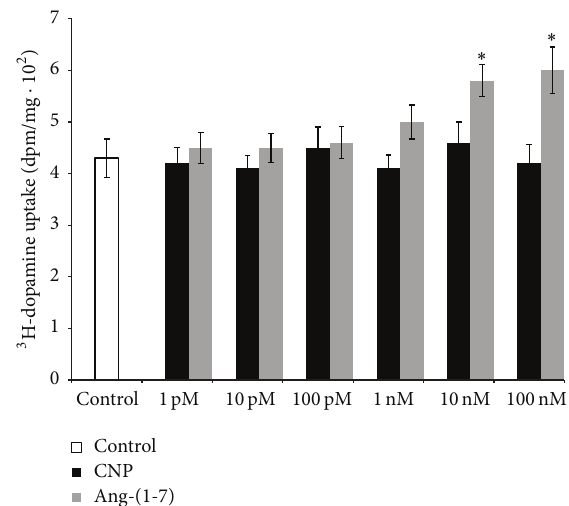
Figure 1: Effects of increasing concentrations (1pM–100nM) of CNP and Ang-(1-7) on 3 H-dopamine uptake in experiments car- ried out in vitro in isolated renal cortex. 3 H-dopamine uptake is expressed as dpm/mg ± SEM. ∗ 𝑝 < 0.05 compared with